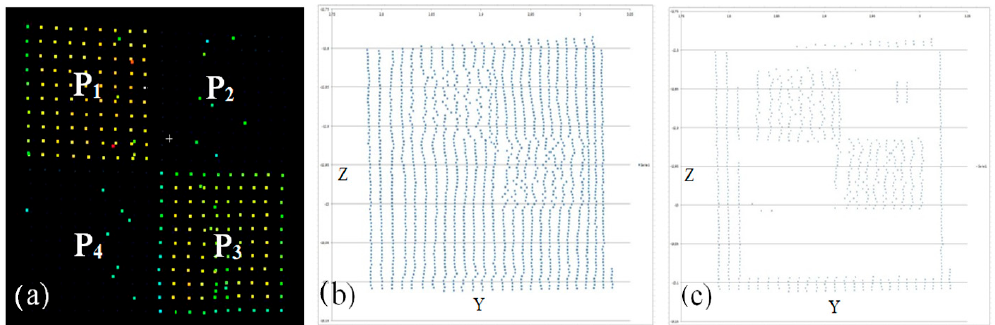
Figure 7. Point cloud segmentation based on the intensity parameter: ( a ) point clouds after intensity thresholding; ( b ) all target points reduced to 2D; and ( c ) points after intensity segmentation with noise. Then, the points are filtered for noises and artefacts on both the YZ and, separately, X